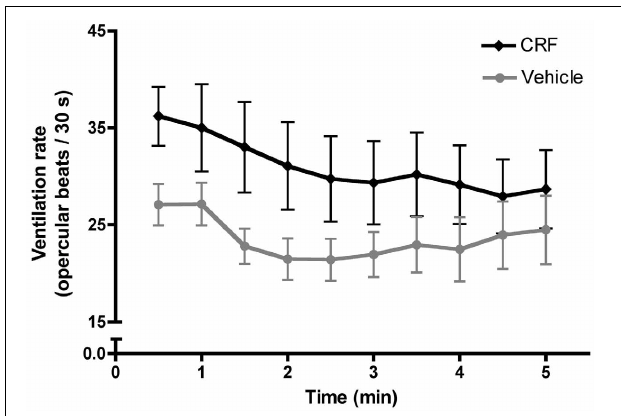
FIGURE 3 | Mean ( ± s.e.m.) ventilation rate, measured as the number of opercular beats recorded in 30s intervals during the first 300s following the initiation of ventilation. A two-way mixed factorial ANOVA with time interval as the within subjects factor and treatment as the between subject factor demonstrated a significant effect of treatment [ F ( 1 , 280 ) = 88 . 11, p < 0 . 0001] and time [ F ( 9 , 280 ) = 3 . 187, p = 0 . 0011] on ventilation rate. Post-hoc analysis revealed that CRF-injected fish had a significantly higher ventilation rate in the first 300s following the initiation of ventilation (independent t -test: t = 4 . 83, d . f . = 298, p < 0 . 0001), indicating the successful injection of CRF. Post-hoc testing showed no significant effect of time on ventilation rate (one-way ANOVA: F ( 9 , 290 ) = 0 . 78, p = 0 .